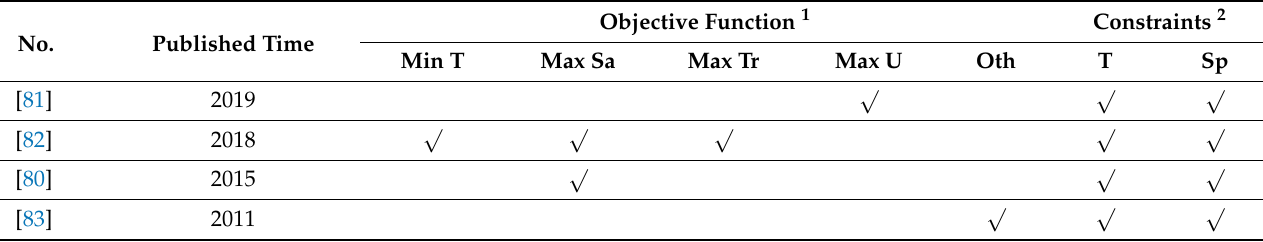
Table 7. Overview of research on intersection scheduling